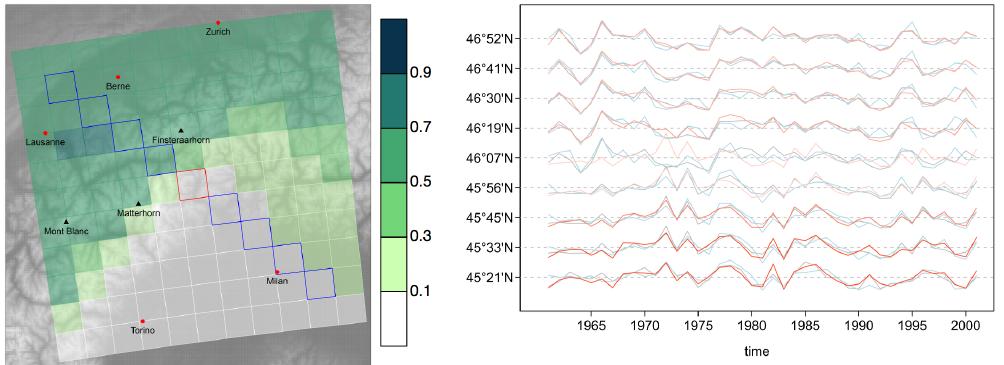
Figure 2. Location representativeness illustrated with a grid box in the Alps (around 46 ◦ 07 (cid:48) N, 8 ◦ 15 (cid:48) E) for winter (DJF). Left panel: correlation of observed grid-box series with surrounding simulated series; red square: position of observational grid box; blue squares: cross section considered in (b) ; grey shading: real-world topography (Amante and Eakins, 2009). Right panel: seasonal mean time series along the cross section from (a) . Blue: observed; red: model at the same grid box; grey: model at the grid box showing the highest correlation at inter-annual scale. The saturation of the red series indicates the correlation between model and observed series at the same grid box. Series are transformed to common mean and unit standard